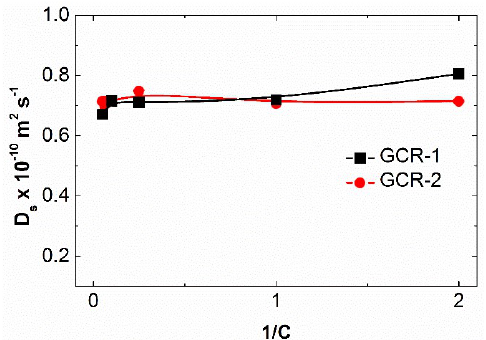
Figure 7. Dependence of the self-diffusion coefficients D s of GCR-1 and GCR-2 on their inverse concentration in 50% DMSO-d6–50% D 2 O, 25 °C.